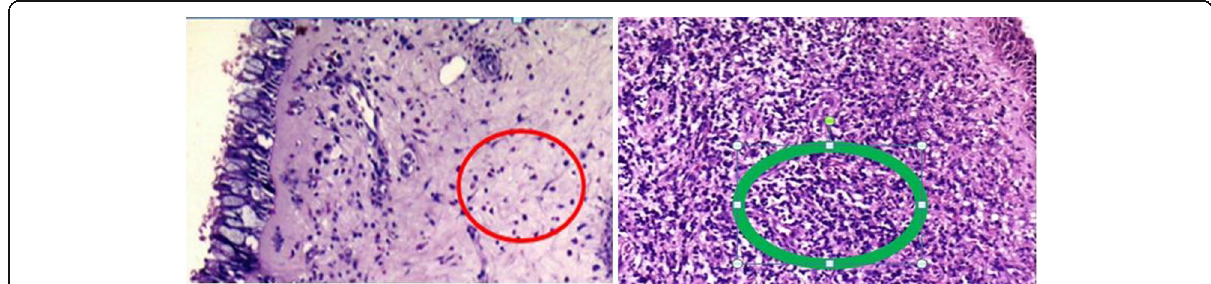
Fig. 4 Nasal turbinate showing eosinophils and plasma cell infiltrate in HIT with AR (red circle) while in DNS and HIT, the subepithelium is densely infiltrated by lymphocytes